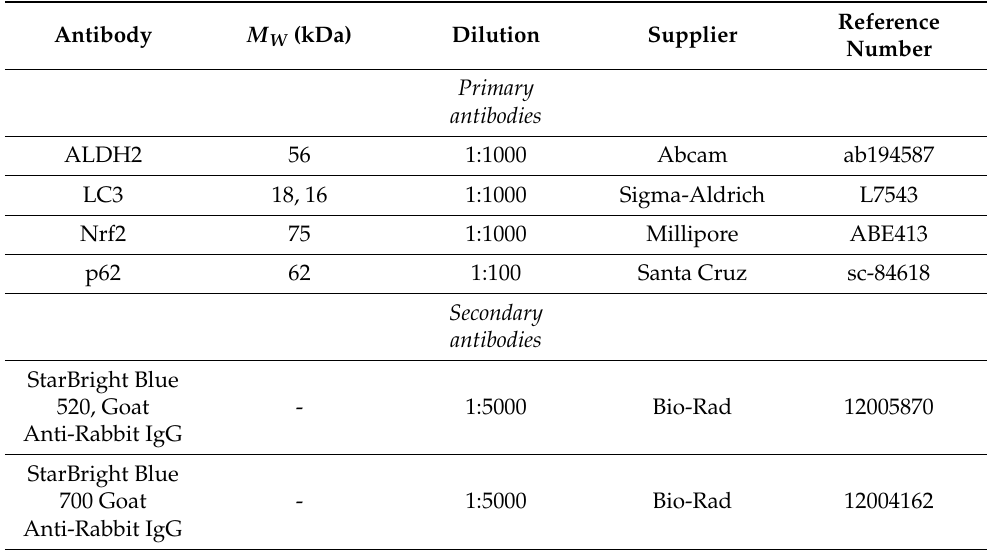
Table 2. Primary and secondary antibodies used in Western blot